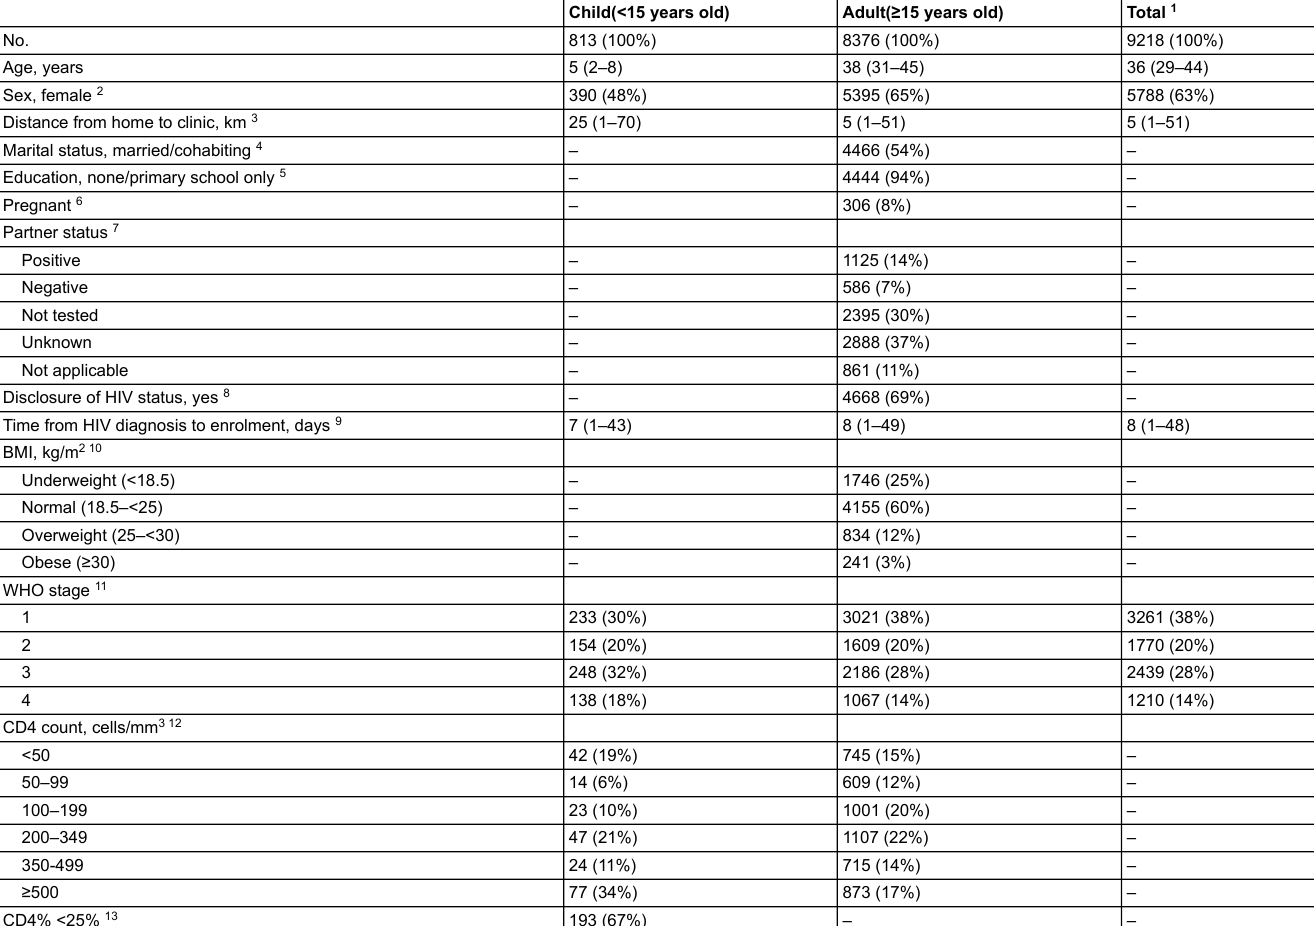
Table 1: Summary of baseline characteristics of participants enrolled in KIULARCO from 2005 to 2016.